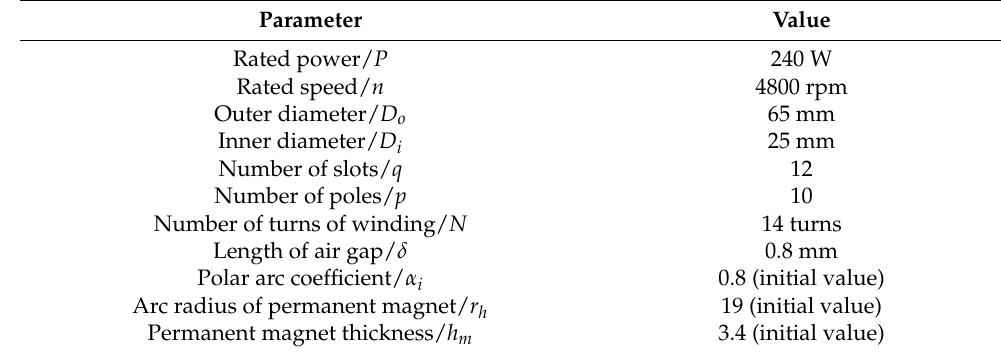
Table 1. Design Parameters of AFPMBLDCM.